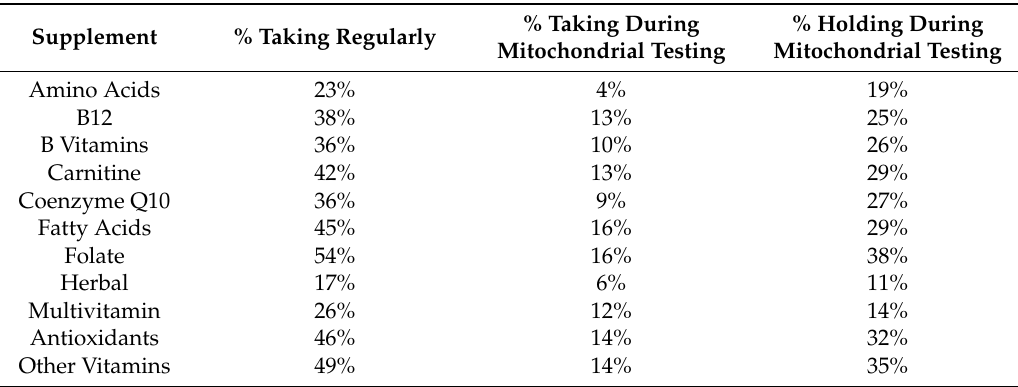
Table 1. Supplements taken by participants.